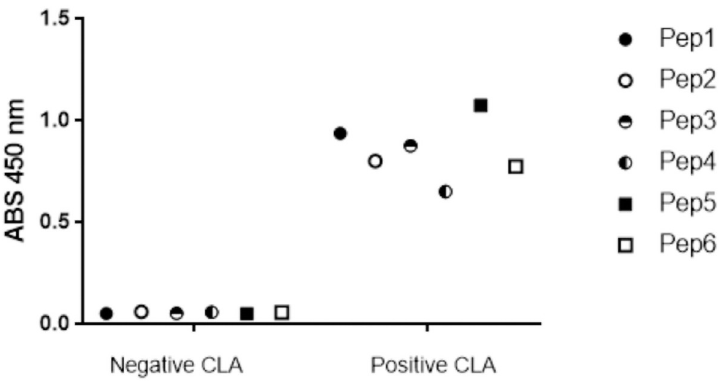
Fig 5. Antigenicity assay of epitopes obtained through bioinformatics tools with naturally infected animal serum (positive for CLA) and healthy serum (negative for CLA) from goat and the determined by ELISA.